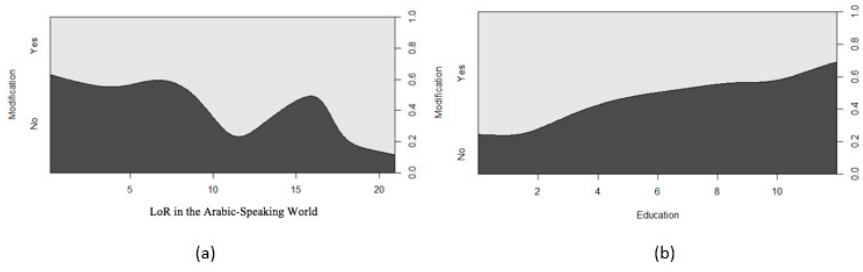
Figure 9. The effects of LoR ( a ) and L1 ( b ) schooling on FDH’s production accuracy of coda CCs. L2 literacy, on the other hand, did not play any significant role in the pattern of coda consonant cluster production ( β = 0.85, SE = 0.55, p > 0.05), though there was a trend for more target-like production by FDH who reported to be literate in Arabic than those who reported to be non-literate (Figure 10). Literate FDH produced coda clusters in 64.28% of the instances, while non-literate FDH produced them in 45% of the instances. Hence, lit- eracy in Arabic—or, more specifically, knowledge of the Arabic script—seems to aid the L2 learners’ acquisition of target-like oral forms, even though this trend was not signifi- cant. Figure 10. Production accuracy of Arabic coda consonant clusters by literate and non-literate FDHs. 3.3. Foreign Accent Rating of FDHs Figure 11 illustrates the rating scale of the foreign accent task and the percentage of total scores given to words produced by the two groups (NS and FDHs). It shows that around 80% of the ratings given to NSs fell into the ‘completely native-like’ category, that is number 9 on the scale. However, the highest percentage of rating in the FDH group went to the ‘not at all native-like’ ranking on the scale, that is number 1.